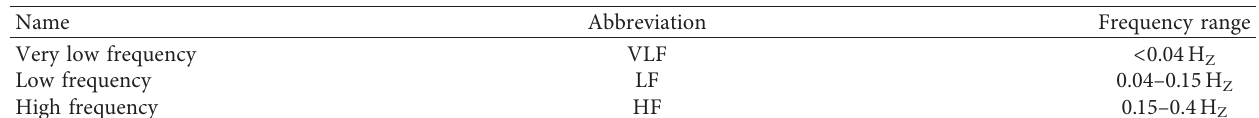
Table 4: HRV spectral